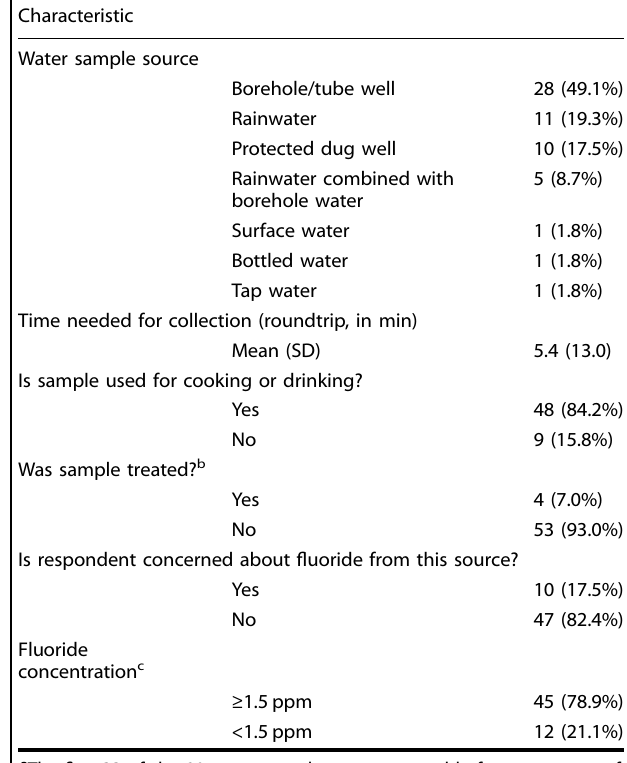
Table 1. Sociodemographic characteristics of participants and their households in the point-of-use fl uoride biosensor study in Nakuru, Kenya ( n = 52).